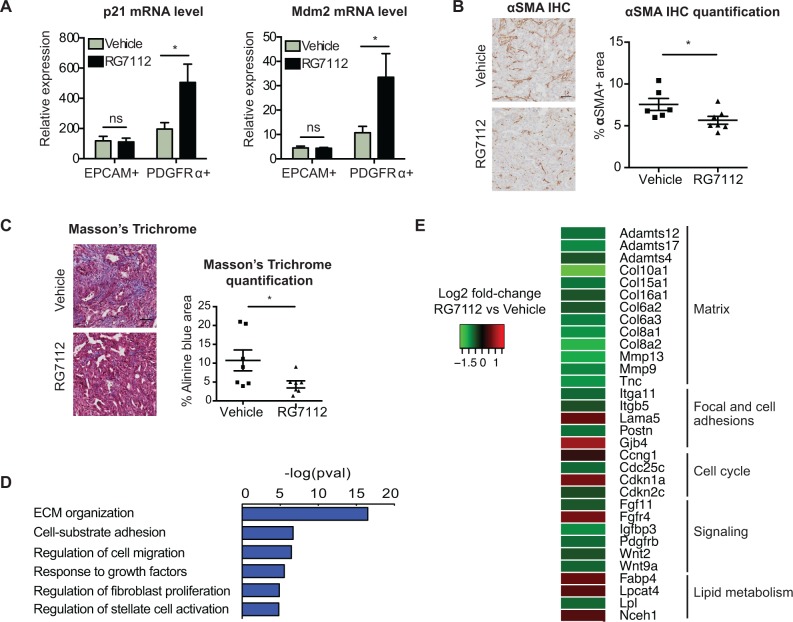
Stromal p53 activation reverses caPSC activation and reduces pancreatic desmoplasia in vivo.(A) Tumor bearing mice were treated with vehicle or RG7112 (200 mg/kg) and were sacrificed. Epithelial cells (EPCAM+) and fibroblasts (PDGFRα+) were isolated from dissociated tumors by FACS. p21 and Mdm2 mRNA levels were quantified by RT-qPCR and normalized to Rplp0 mRNA. Bars represent mean +SD of 3 different mice. *, p<0.05 by two-way ANOVA. (B-C) Mice transplanted with KPC cells were treated for 15 days with Vehicle or RG7112 (200 mg/kg) starting day 8 post-transplantation. Tumors were harvested and fixed in formalin. FFPE sections were subjected to (B) IHC using an αSMA antibody and (C) Masson’s Trichrome staining. Representative images are shown on the left and quantification on the right. At least eight 15X fields were quantified using Inform 2.1 software and mean values for each tumor are plotted on the graph. *, p<0.05 by Student’s test. Scale bar, 50 μM. (D) Metascape analysis was performed on RG7112 downregulated and upregulated genes (fold change >1.4 or <0.7, adjusted p<0.05). Six of the twenty most significant canonical pathways are shown and -log(pval) are indicated. (E) Heatmap representing selected genes from the RNA-seq analysis. Data are represented as log2 fold change, RG7112 versus Vehicle.